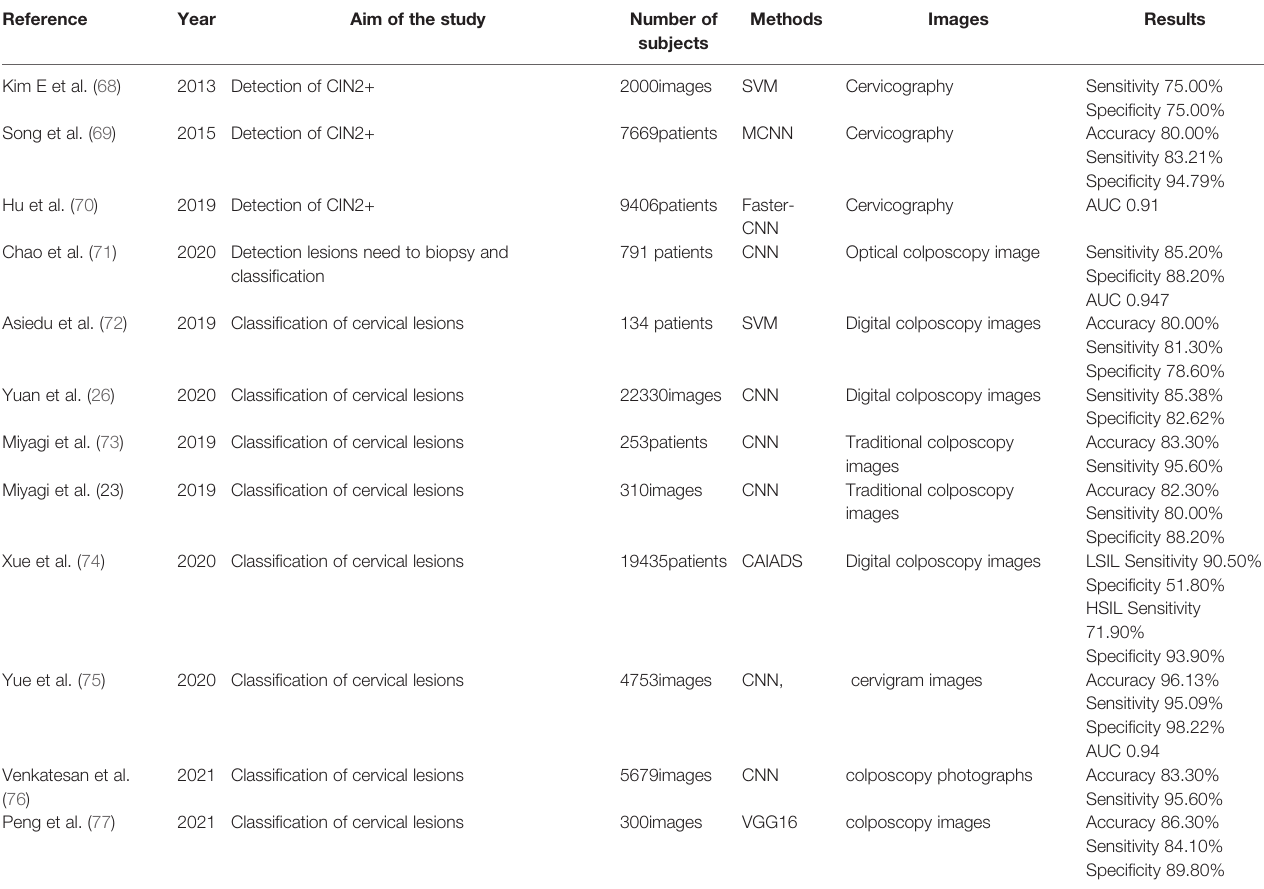
TABLE 6 | Application of AI in